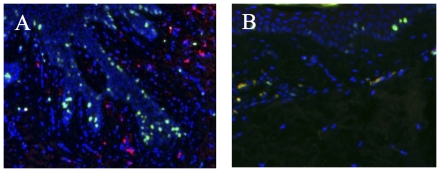
Proliferation of keratinocytes in grafted animals.After the third graft, the proliferation of keratinocytes in the epidermis-dermis junction is revealed by the Ki67 immunostaining (in green) in the irradiated skin of grafted animals (A) versus controls (B).